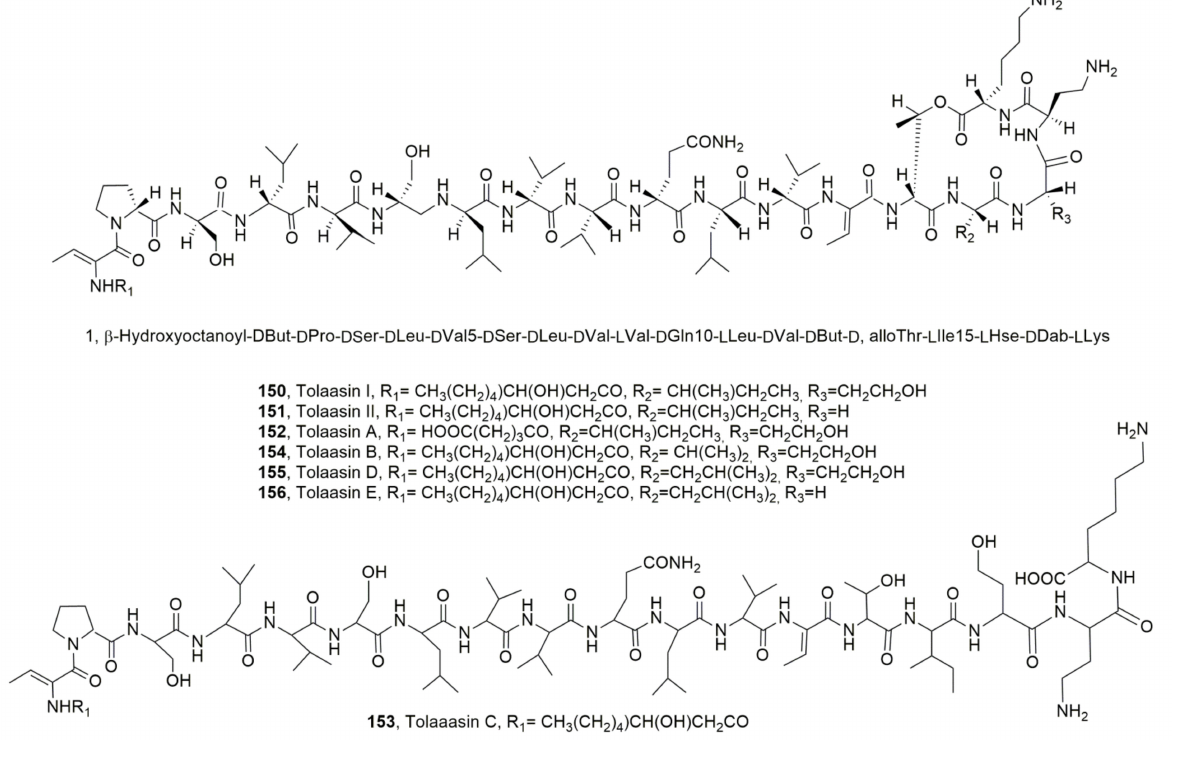
Figure 17. Structure of lipodepsipeptides produced by Pseudomonas tolaasii ( 150 – 156 ).